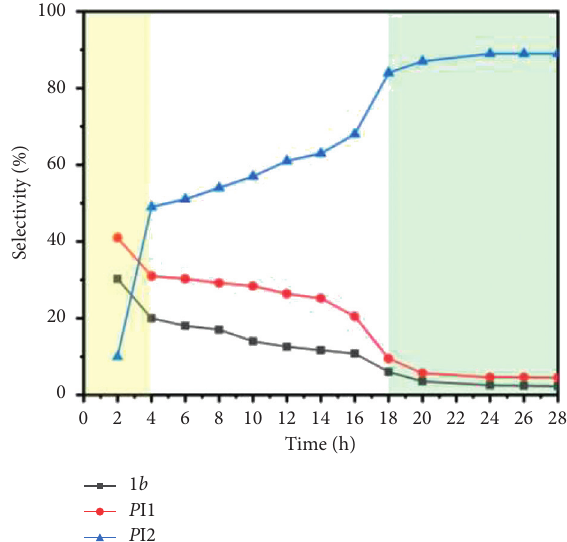
Figure 1: Evolution of the selectivity of the intermediate products (PI1 and PI2) and the pyrrolic product 1b as a function of time.